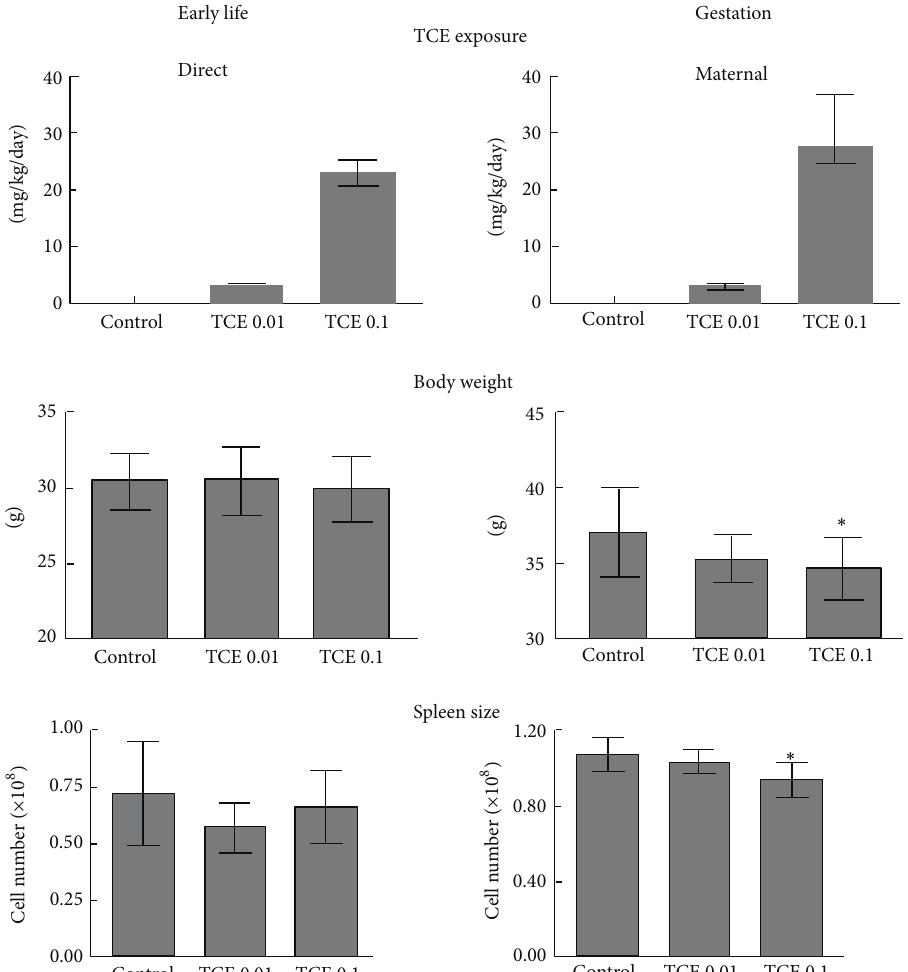
Figure 1: Characteristics of two windows of developmental TCE exposure. Female mice were exposed to TCE (0.01 or 0.1mg/mL) during gestation only, or during early life only (lactation and 4 weeks of direct exposure). All of the developmentally-exposed mice were examined at PND49. For the gestation only exposure, maternal TCE ingestion based on water consumption was presented. For the early life exposure direct TCE ingestion of the pups postweaning based on water consumption was presented. Body weight and spleen cell numbers (mean ± SD) were determined at PND49. ∗ Significantly different ( 𝛼 < 0.05 ) compared to control